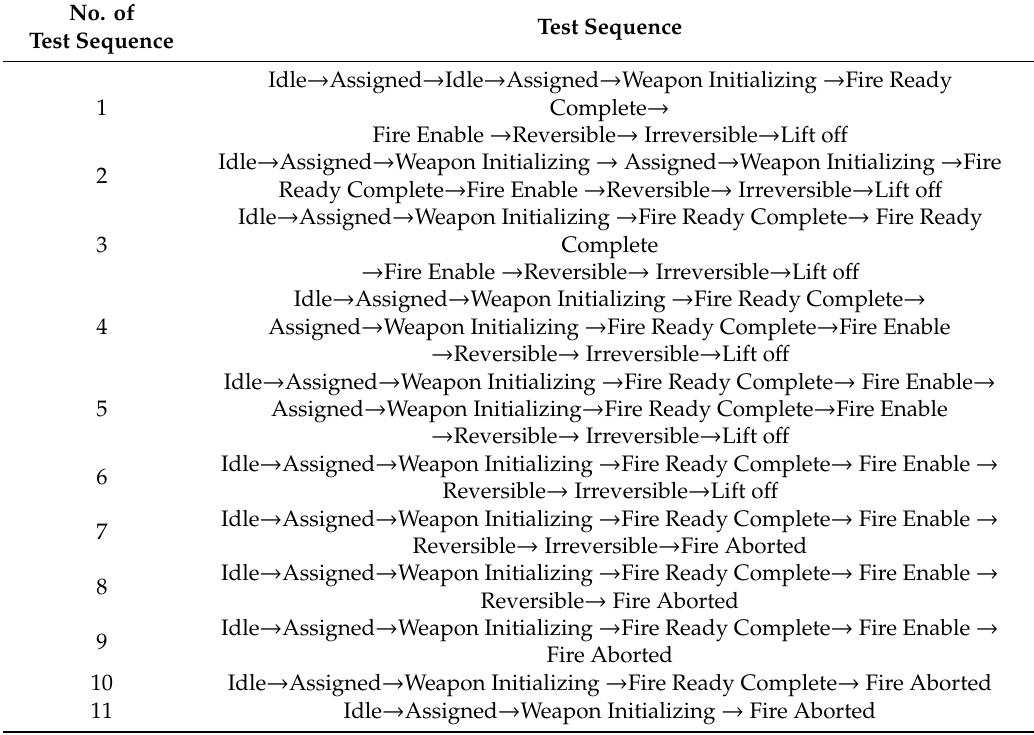
Table 6. Test suite using the proposed method.